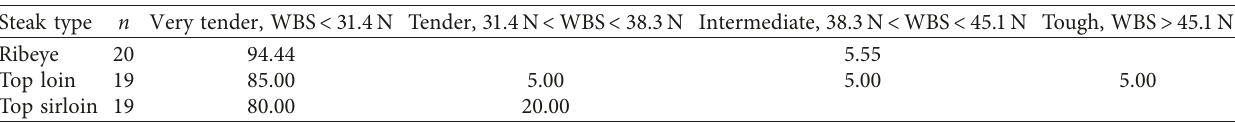
WBS � Warner–Bratzler shear force values. n � number of